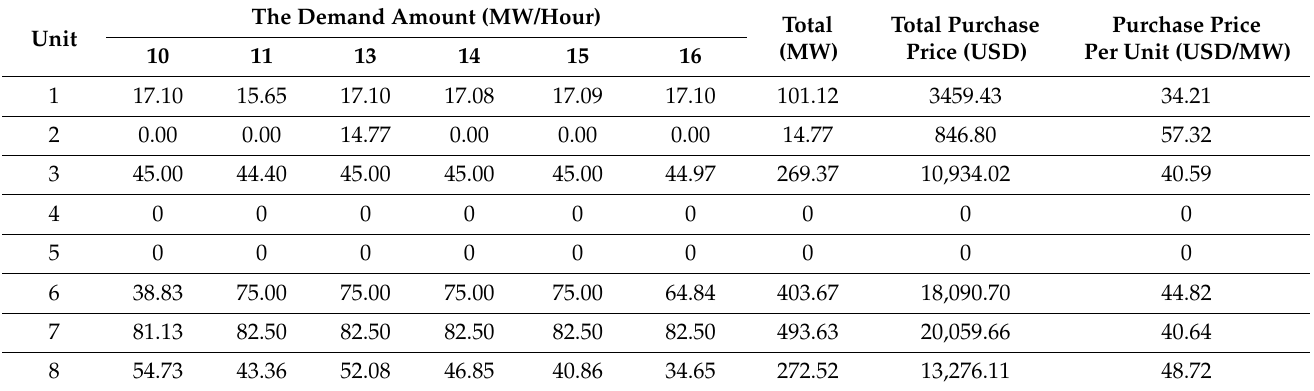
Table 7. Bidding demand amount and price in Case